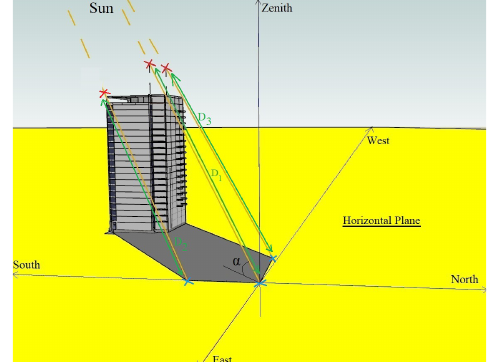
Figure 2 . Energy efficiency protection and overshadowing open space points extraction in order to model it using B-